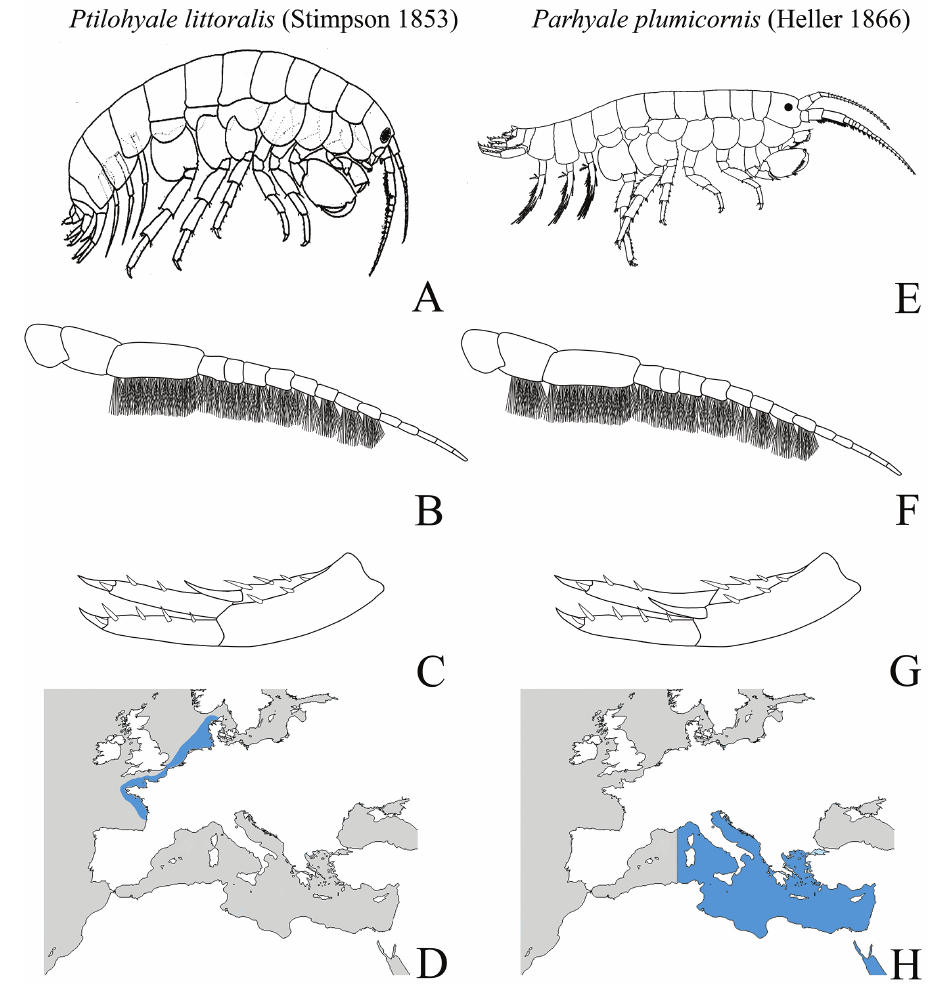
Figure 6. Comparison between Ptilohyale littoralis and Parhyale plumicornis diagnostic characters and distributions. Ptilohyale littoralis : A illustration of male (Bousfield and Hendrycks 2002) B antenna II 5th male with brush-setae starting at the peduncular segment C right uropod I with peduncular distome- dial robust seta D species distribution along the Atlantic coast. Parhyale plumicornis : E illustration of male (Iaciofano and Lo Brutto 2017) F antenna II male with brush setae starting at the 4 th peduncular segment G right uropod I with peduncular distolateral robust seta H species distribution along the Mediterranean and Red Sea